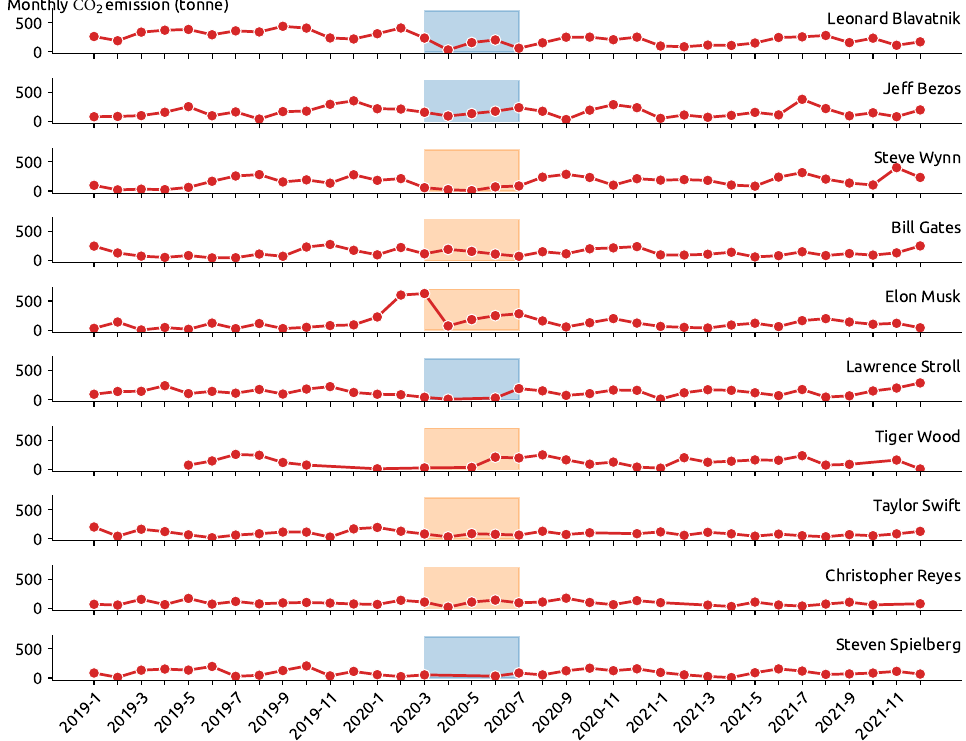
Figure 8. Monthly carbon emission of the top 10 private jet owners from our dataset in the United States. The colored period marks the beginning of the COVID-19 pandemic when a significant decrease in air transport occurred. However, the same does not apply to all jet owners (marked in